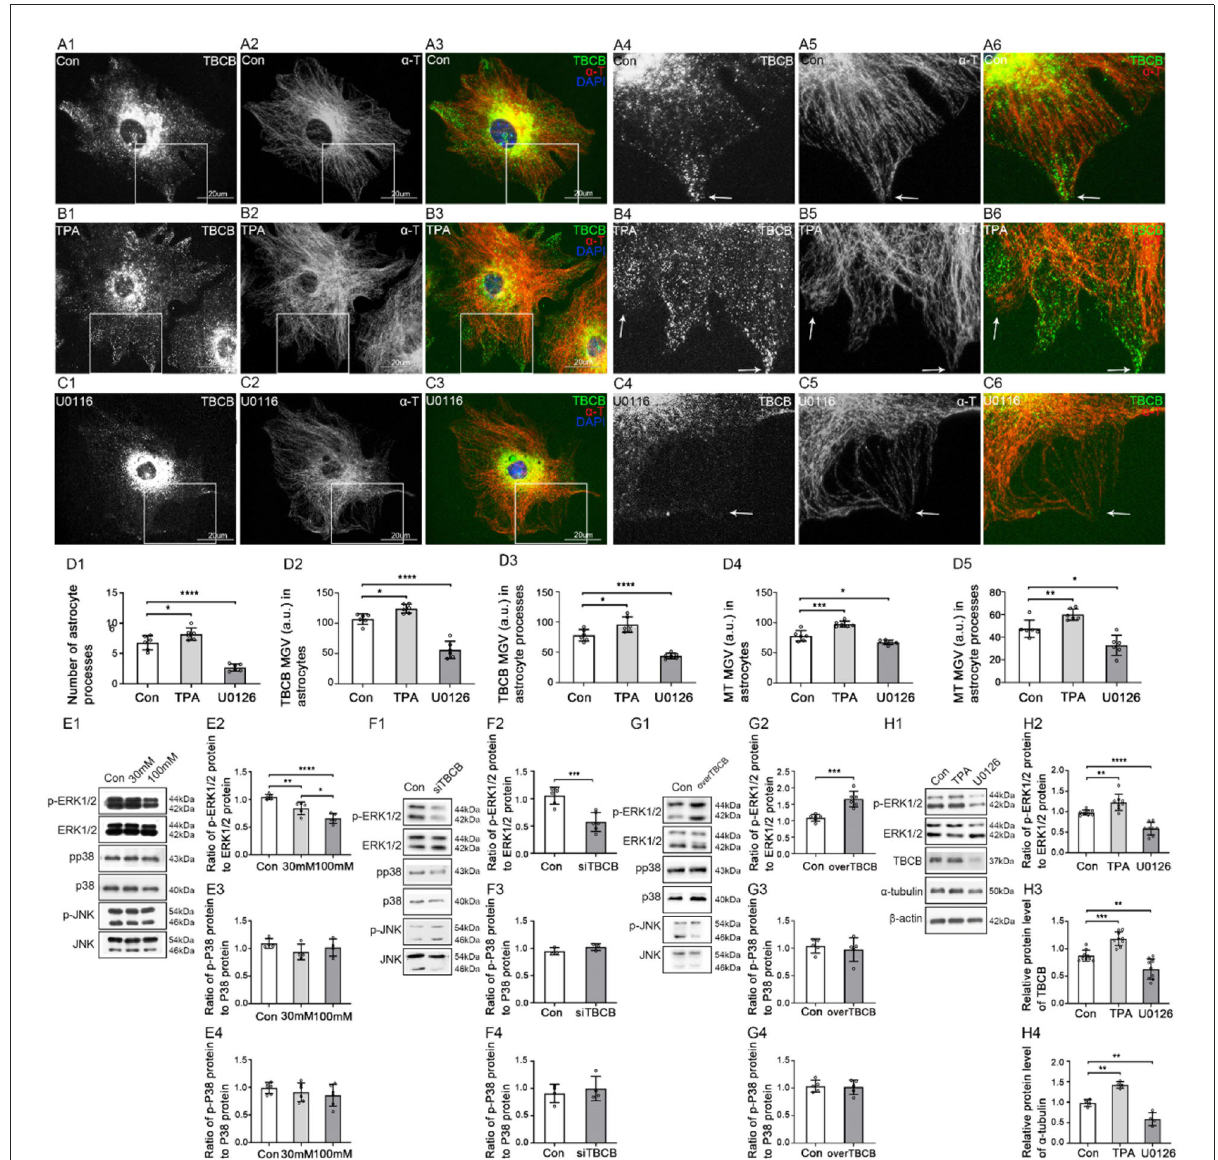
FIGURE8 Changes in protein levels in MAPK signaling pathway after chronic alcohol exposure or TBCB interference, and distribution and protein levels of TBCB and α -tubulin in astrocytes after interfering with ERK1/2 signaling pathway. (A–C) Immunofluorescence showed that TBCB (green signal) was co-expressed with α -tubulin (red signal) in astrocytes both in the control group [Con (A) ] and ERK1/2 agonist group [TPA (B) ] or ERK1/2 inhibitor group [U0126, (C) ]. (D) The number of astrocyte processes and mean gray value (MGV) of TBCB and MT in astrocytes and its processes (MGV = Integrated Density/Area) after interfering with the ERK1/2 signaling pathway. (E–G) Western blot analysis of phosphorylation levels and relative quantitative analysis of MAPK (ERK1/2, p38, JNK) signaling pathways in astrocytes under various interfering factors ( n = 6, p < 0.05). (H) Western blot analysis of the ratio of p-ERK1/2 to ERK1/2, and protein levels of TBCB and α -tubulin in astrocytes after TPA pretreatment or after U0126 pretreatment ( n = 6, p < 0.05). (A–H) Number of panels. * p < 0.05, ** p < 0.01, *** p < 0.001, **** p < 0.0001.